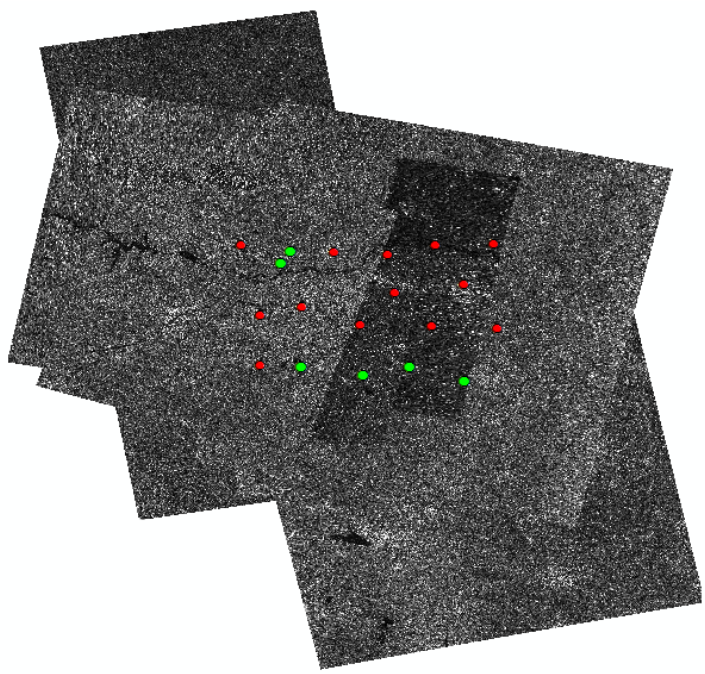
Figure 6. Experimental dataset distribution in Songshan